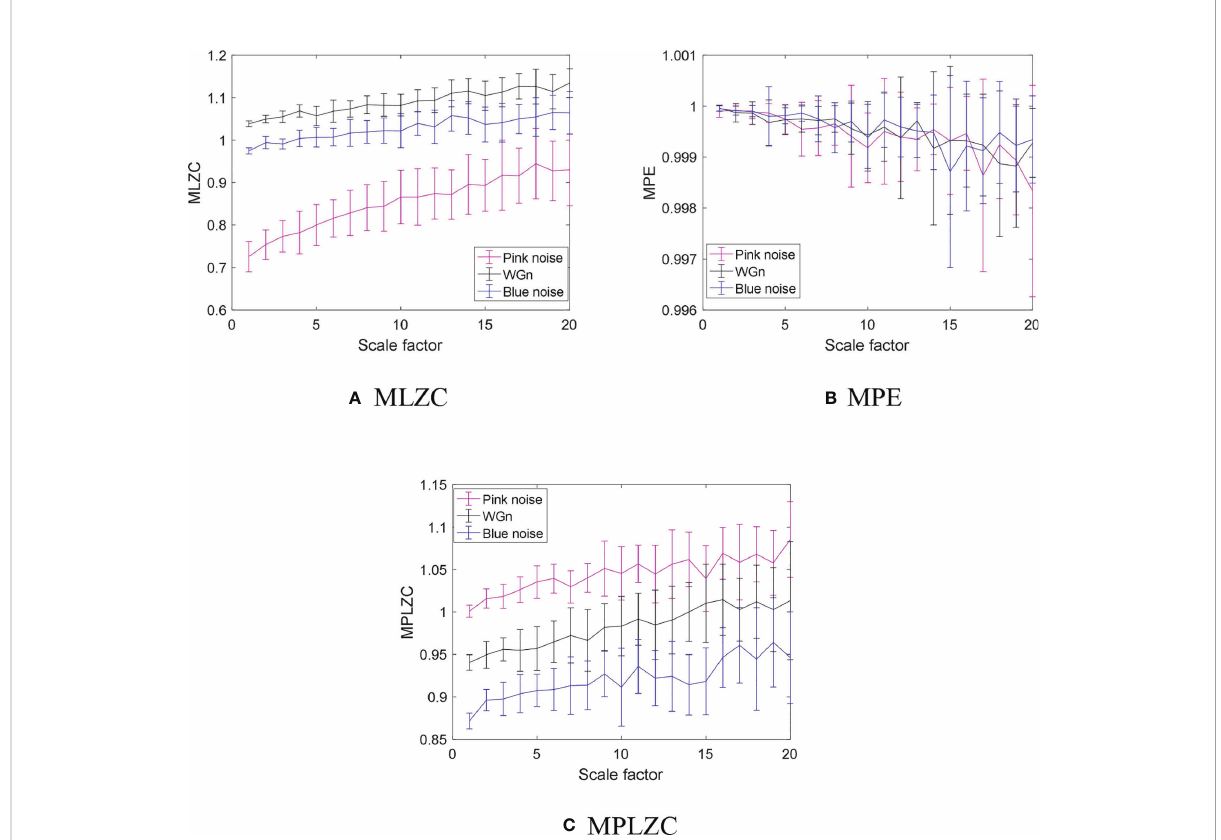
FIGURE 5 Means and standard deviations of complexity for three noise signals under different SFs: (A) MLZC, (B) MPE, (C) MPLZC.